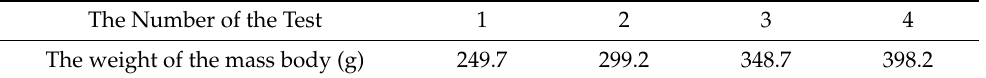
Table 4. Weight of mass body in different test conditions for the magnetic repulsive force tester. The Number of the Test The weight of the mass body